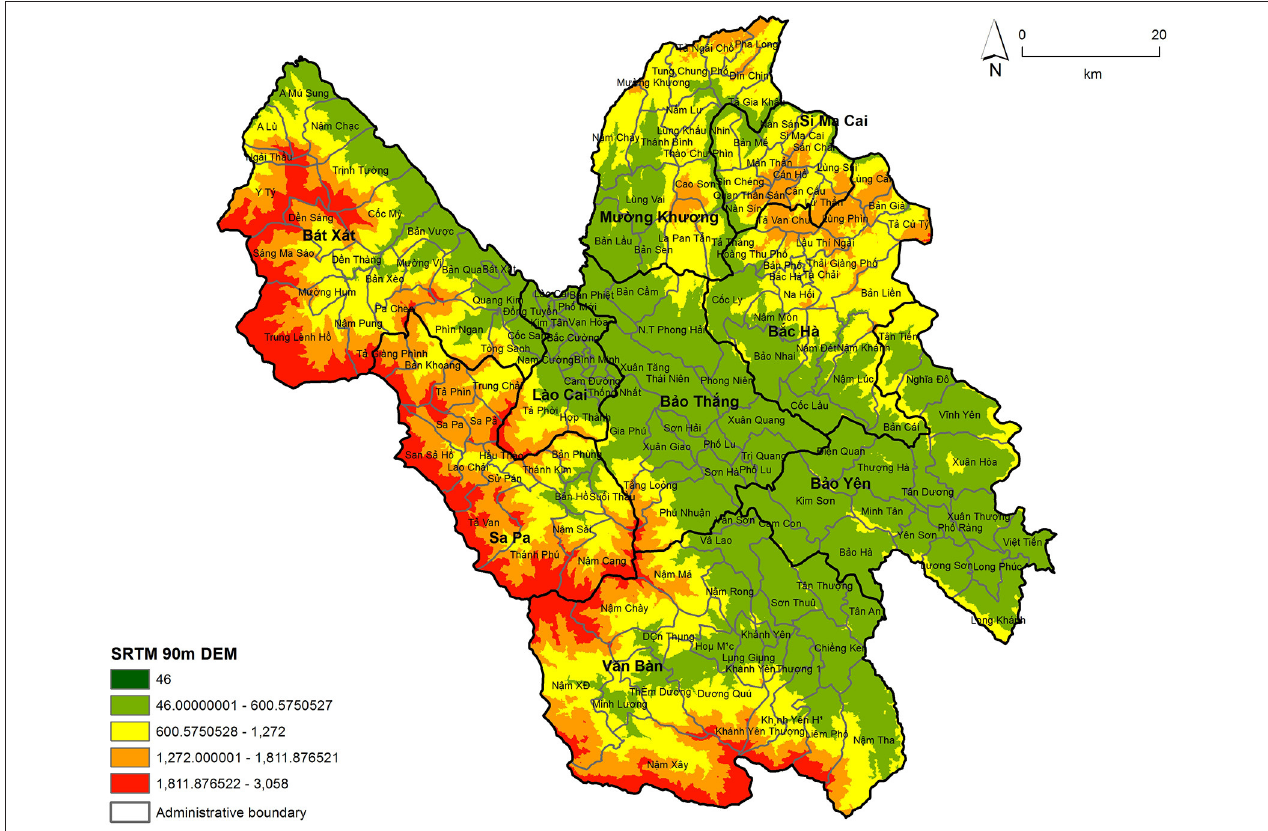
FIGURE 1 | Administrative map of Lao Cai province. Source: SRTM downloaded from http://srtm.csi.cgiar.org/SELECTION/inputCoord.asp; Data: SRTM 90m digital Elevation Model (DEM) using ArcGIS10 http://srtm.csi.cgiar.org/SELECTION/listImages.asp.